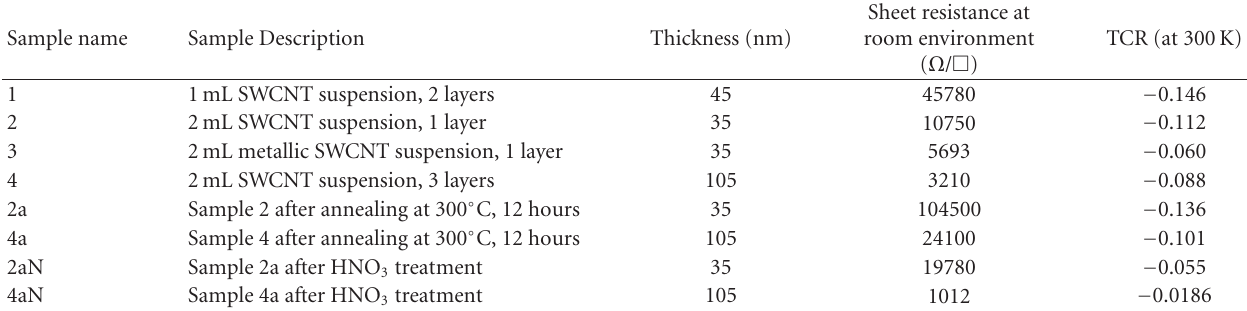
Table 1: The fabrication parameters, thickness, sheet resistance, and TCR at 300 K of the SWCNT thin